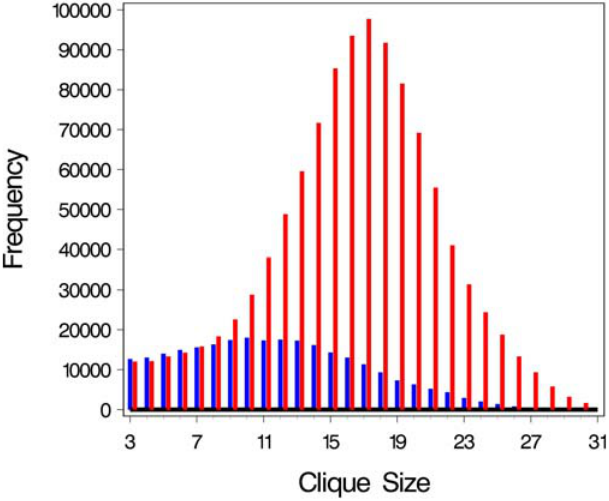
Figure 4. Distribution of Clique Sizes in Control and IR Maximum clique and average clique sizes were larger in IR (red bars) than control (blue bars).